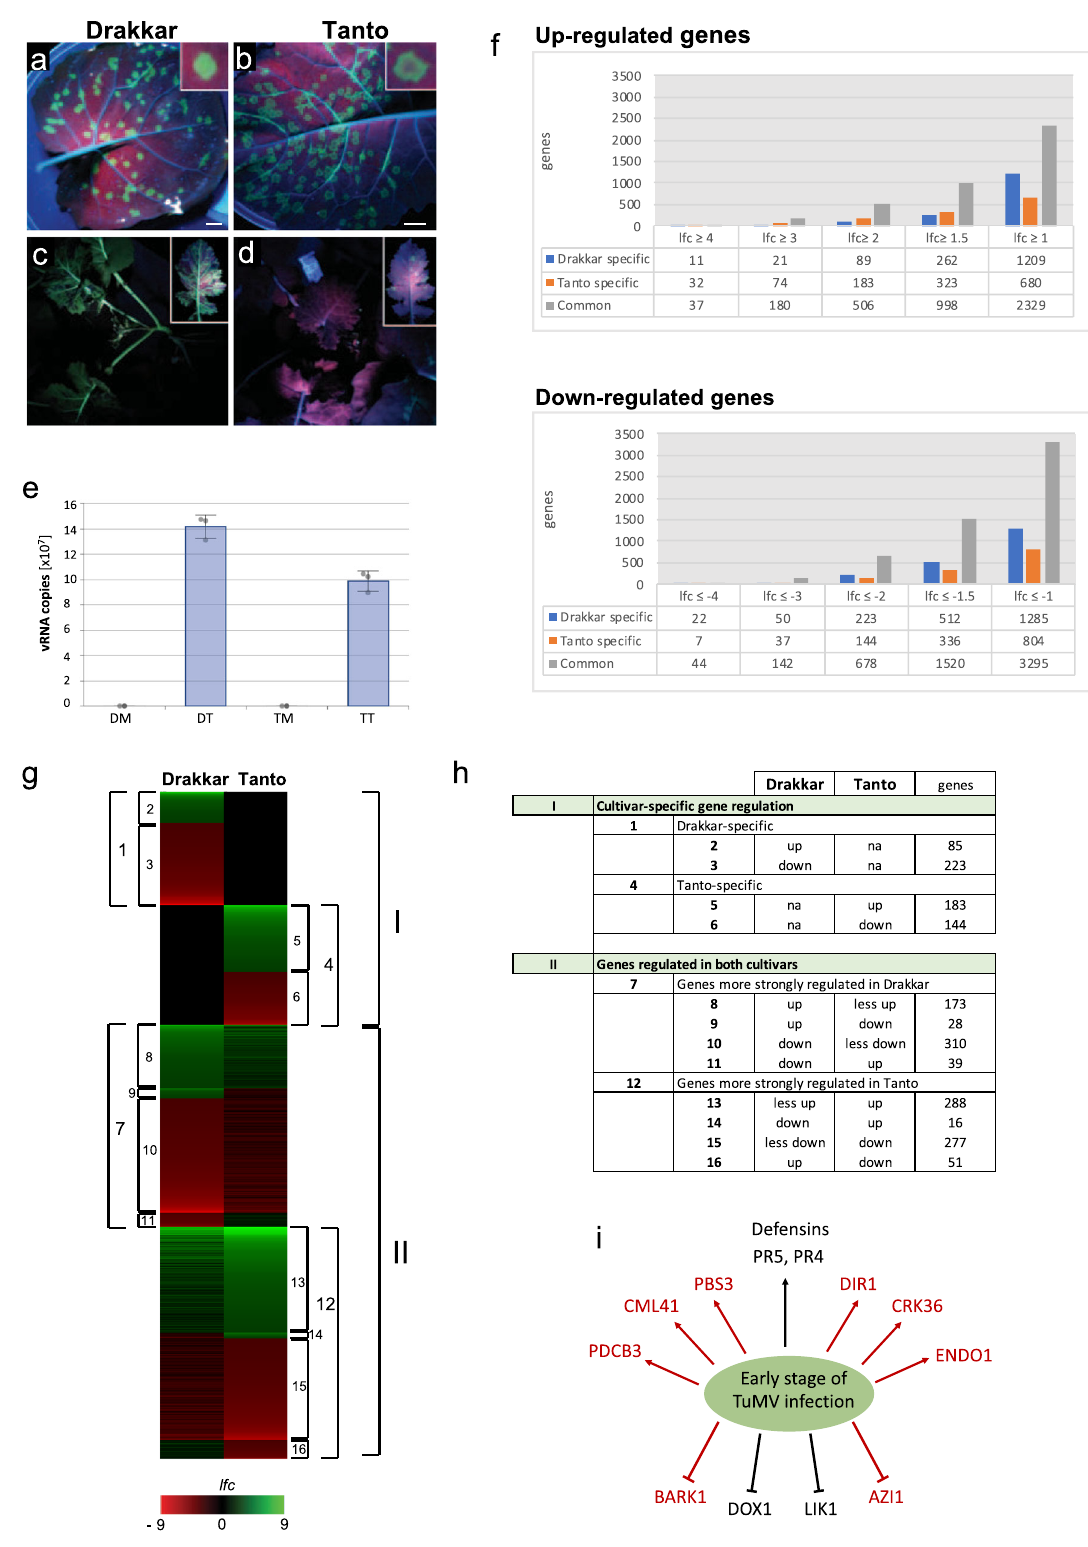
activation of pathogen/microbe-associated molecular pattern (PAMP/MAMP) receptor complexes with downstream intracel- lular signaling 47 . Although further functional studies are needed, these fi ndings suggest that PTI and inhibition of PD conductivity may contribute to the enhanced systemic antiviral resistance in Tanto. On the other hand, Tanto strongly